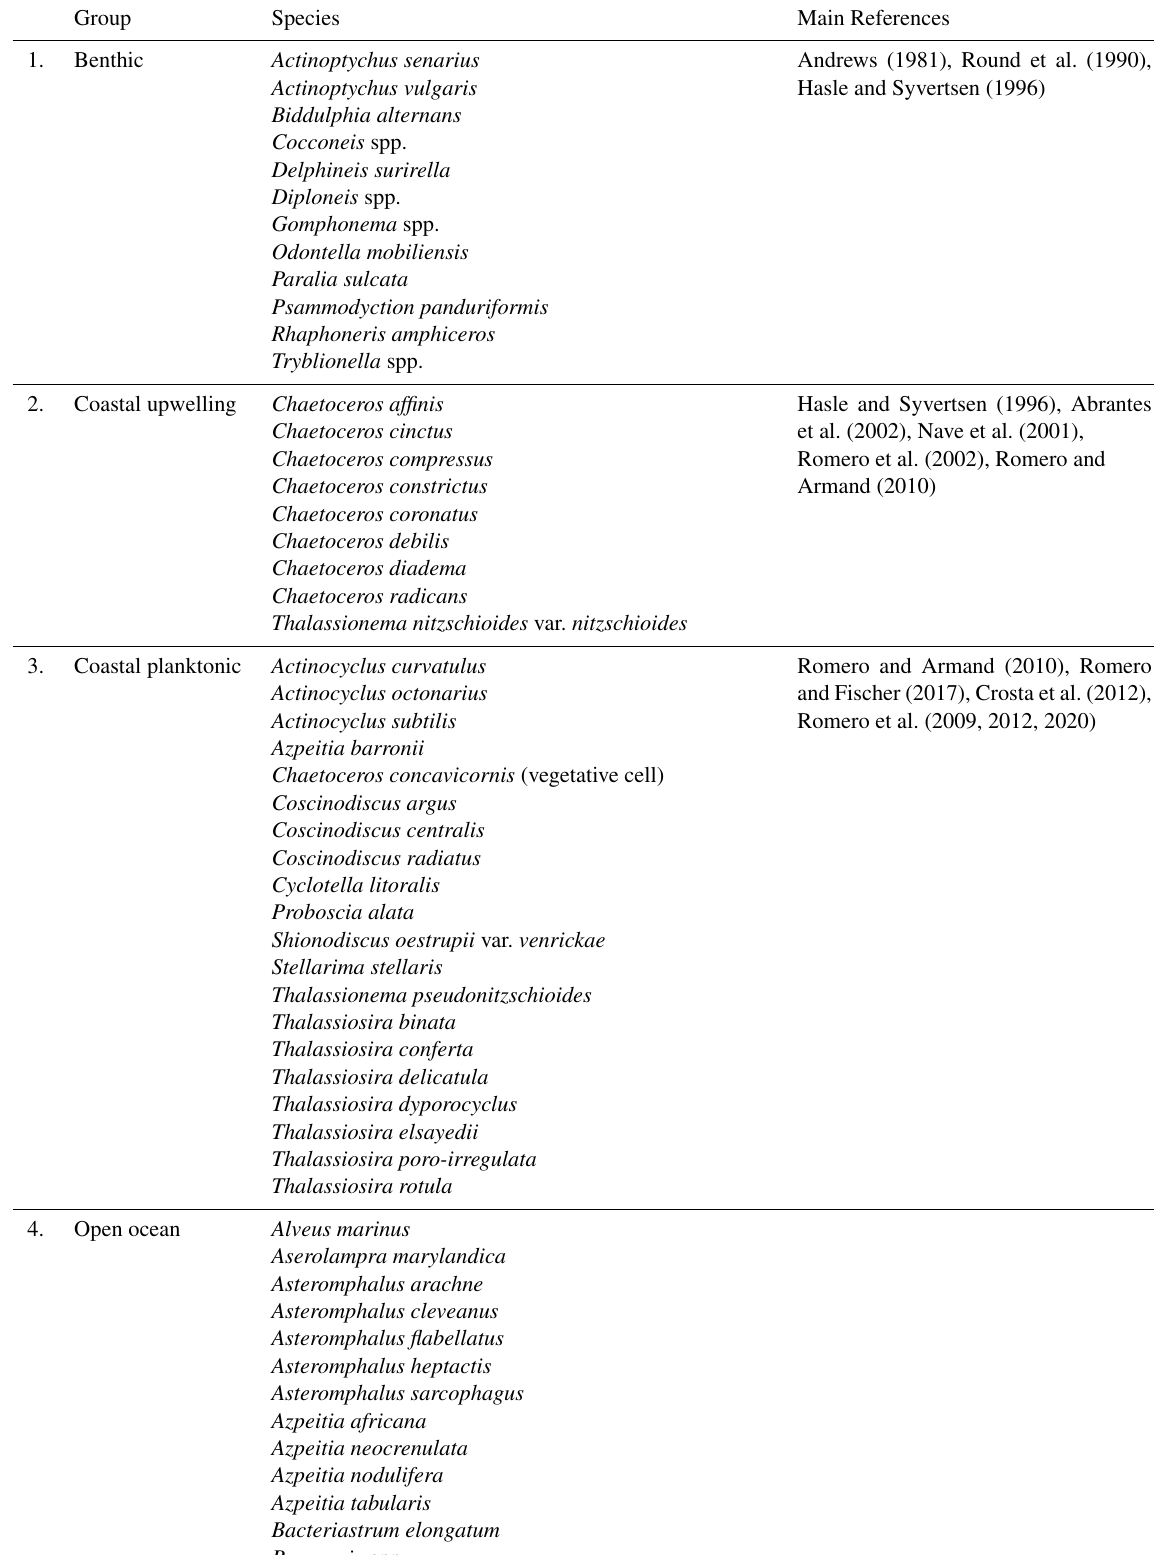
Table 3. Species composition of the assemblage of diatoms at the site CBmeso between March 1988 and June 2009. Group